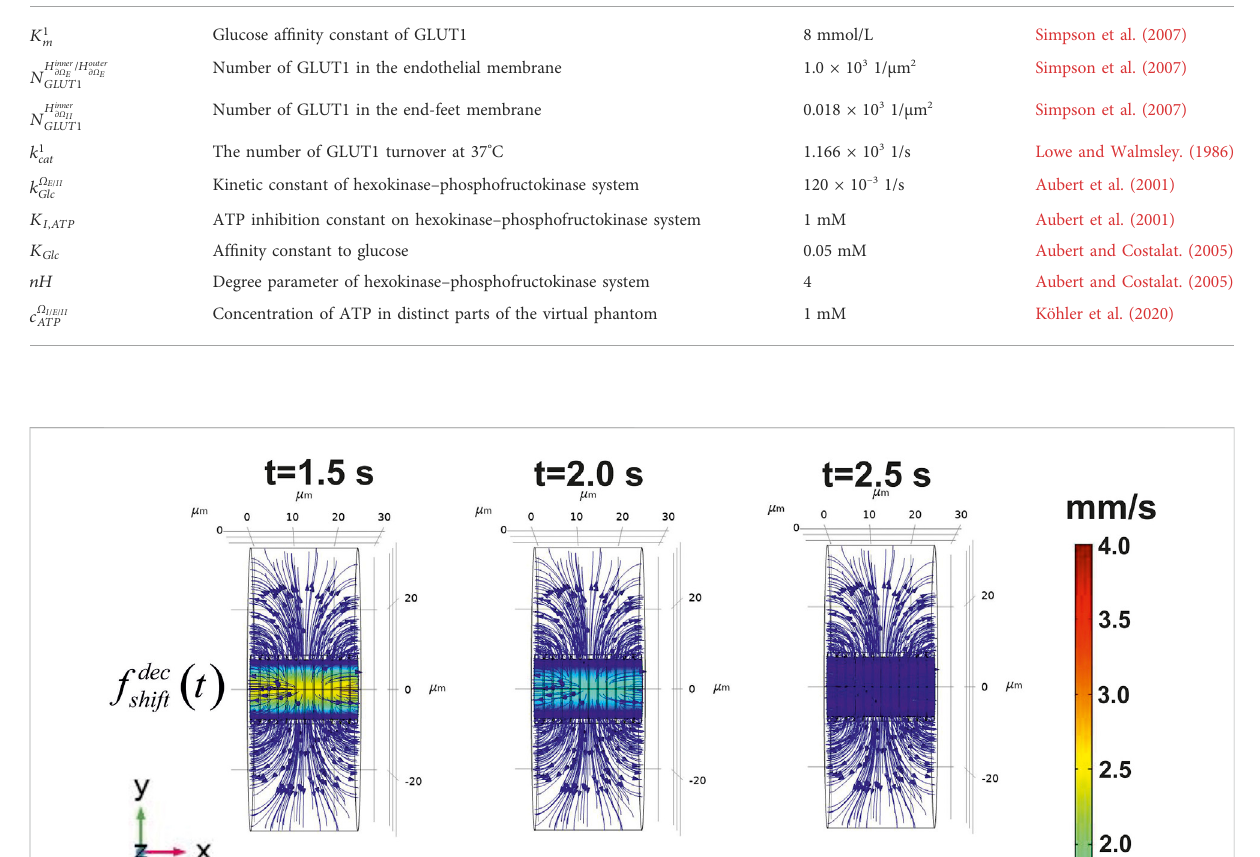
TABLE 4 The parameters of transmembrane glucose transport and the constants of consumption rates for glucose. Symbol